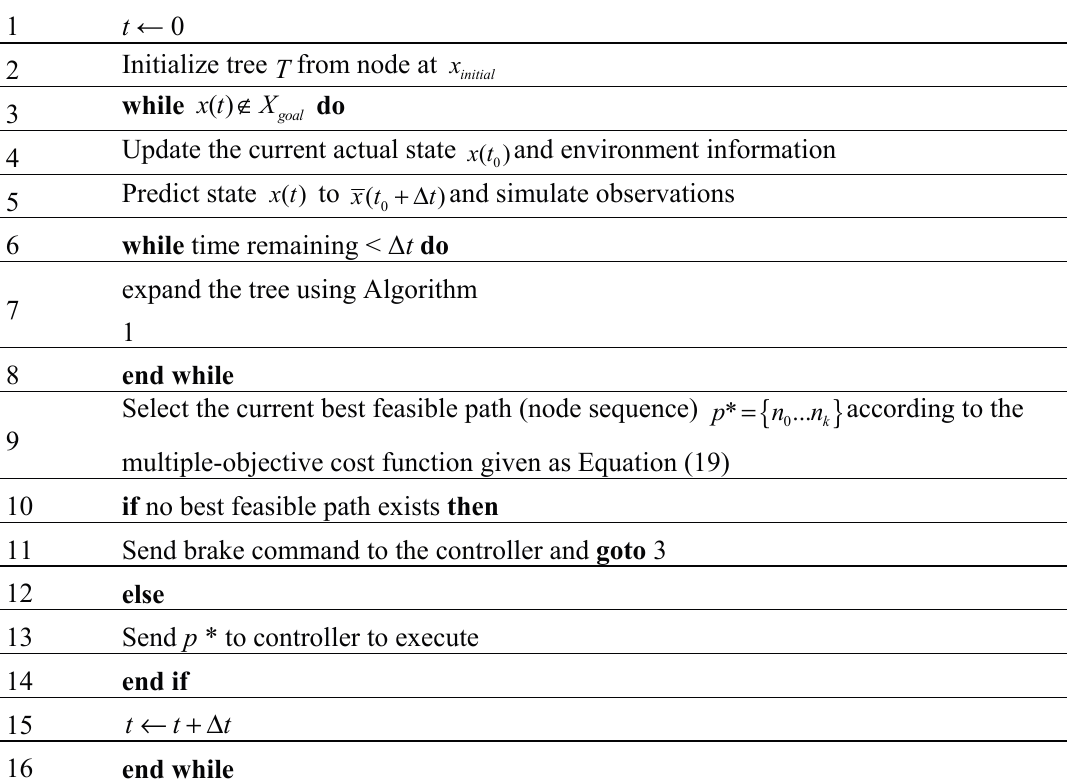
Algorithm 3. Closed-loop random belief tree: execution loop.